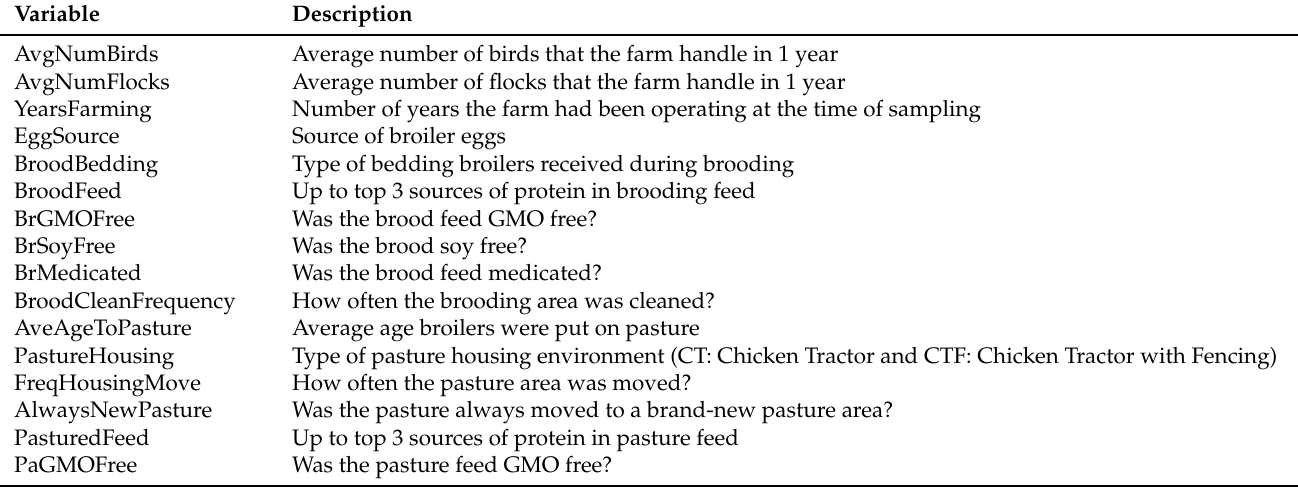
Table A1. Poultry management